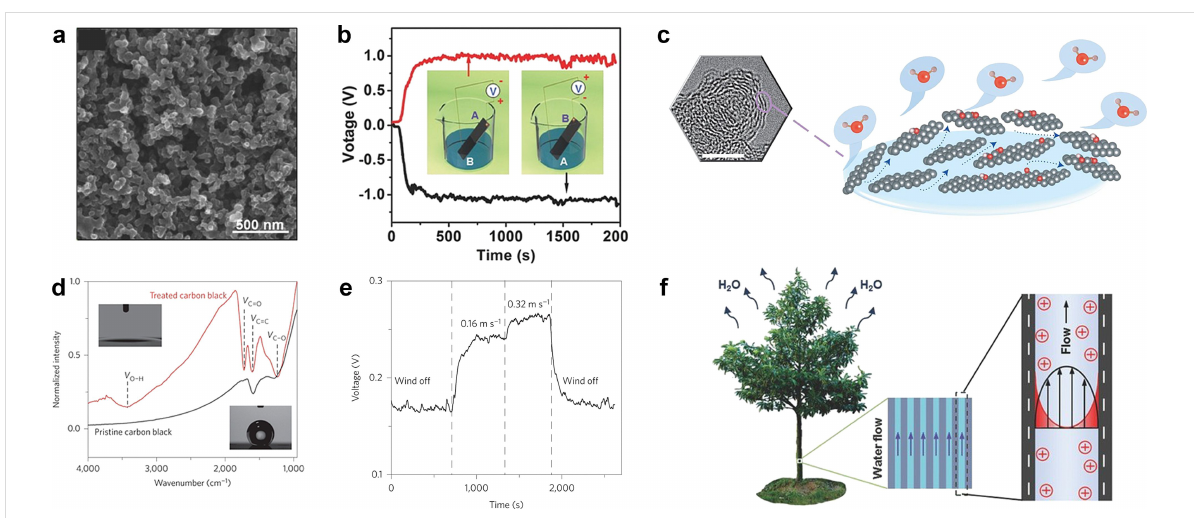
Figure 3: (a) SEM image of the porous carbon film. (b) The porous carbon film power generation device and its performance are depicted schemati- cally. Figure 3a, 3b, and 3f were reproduced from [9], Ding, Tianpeng et al., “All-Printed Porous Carbon Film for Electricity Generation from Evapora- tion-Driven Water Flow”, Adv. Funct. Mater., with permission from John Wiley and Sons. Copyright © 2017 WILEY-VCH Verlag GmbH & Co. KGaA, Weinheim. This content is not subject to CC BY 4.0. (c) HR-TEM image of CB and a schematic depiction of water evaporation and induced water flow in CB. (d) After annealing and air plasma cleaning, changes in hydrophilicity and functional groups of the porous carbon film. (e) Voltage between the two electrodes at different wind velocities. Figure 3c, 3d, and 3e are from [46] and were reprinted by permission from Springer Nature from the journal Nature Nanotechnology (“Water-evaporation-induced electricity with nanostructured carbon materials“ by G. Xue; Y. Xu; T. Ding; J. Li; J. Yin; W. Fei; Y. Cao; J. Yu; L. Yuan; L. Gong; J. Chen; S. Deng; J. Zhou; W. Guo), Copyright 2017 Springer Nature. This content is not subject to CC BY 4.0. (f) Schematic diagram of the liquid flow-induced streaming potential in a natural